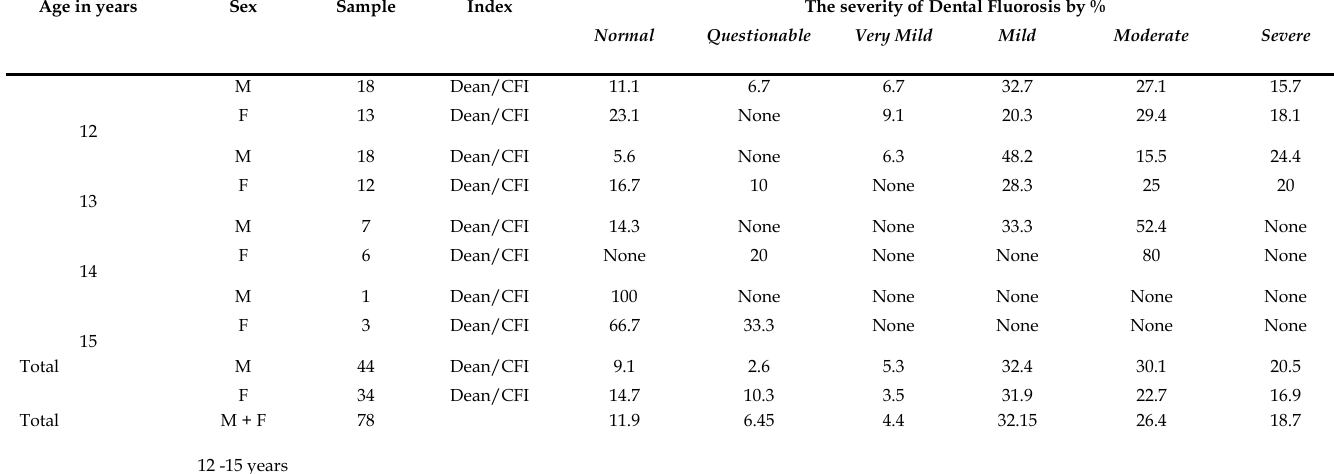
Table 2: he severity of dental fluorosis in the urban studied population Age in years Sex Sample